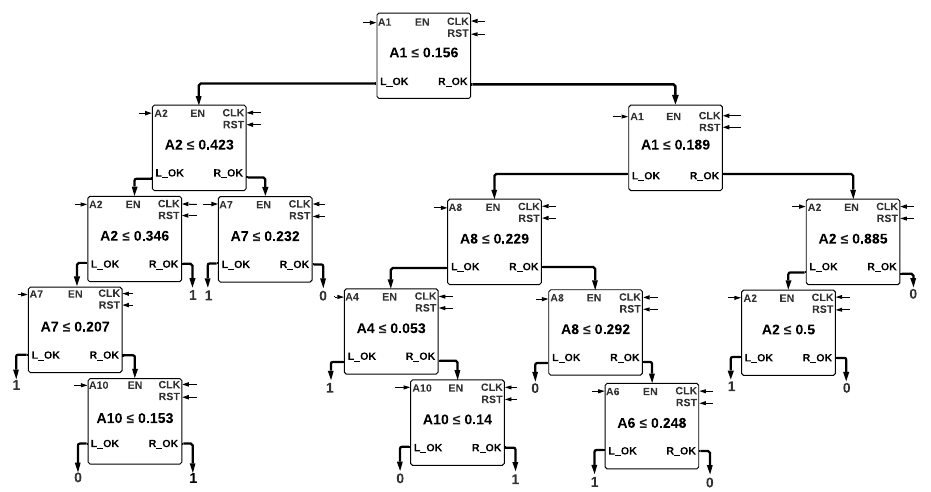
Figure 7. Decision Tree with a Depth of